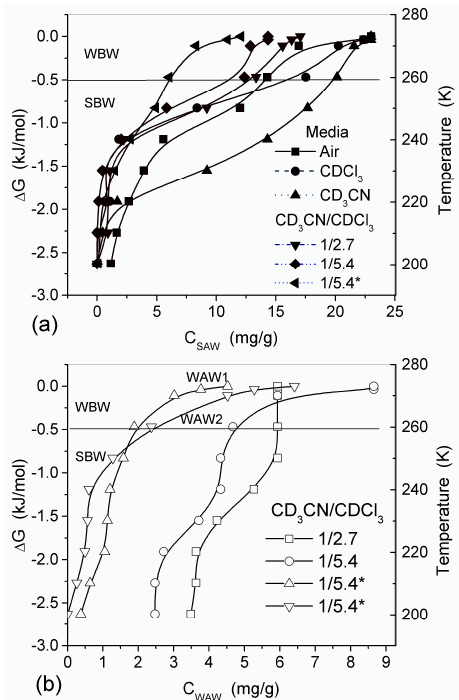
Figure 16. Temperature dependence of the amount of ( a ) SAW and ( b ) WAW and the relationships between changes in the Gibbs free energy and the amounts of SAW and WAW in HA/A-300 composites CM1 and CM2 (*).